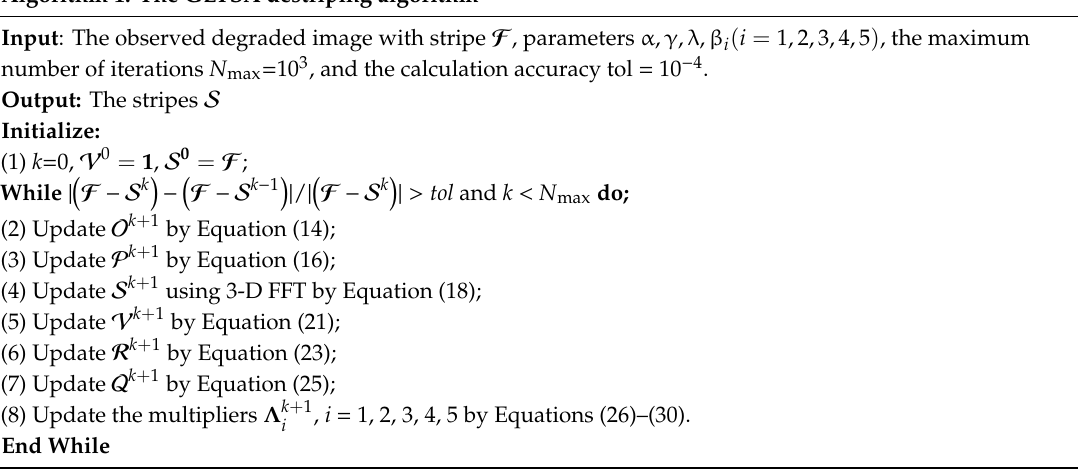
Algorithm 1. The GLTSA destriping